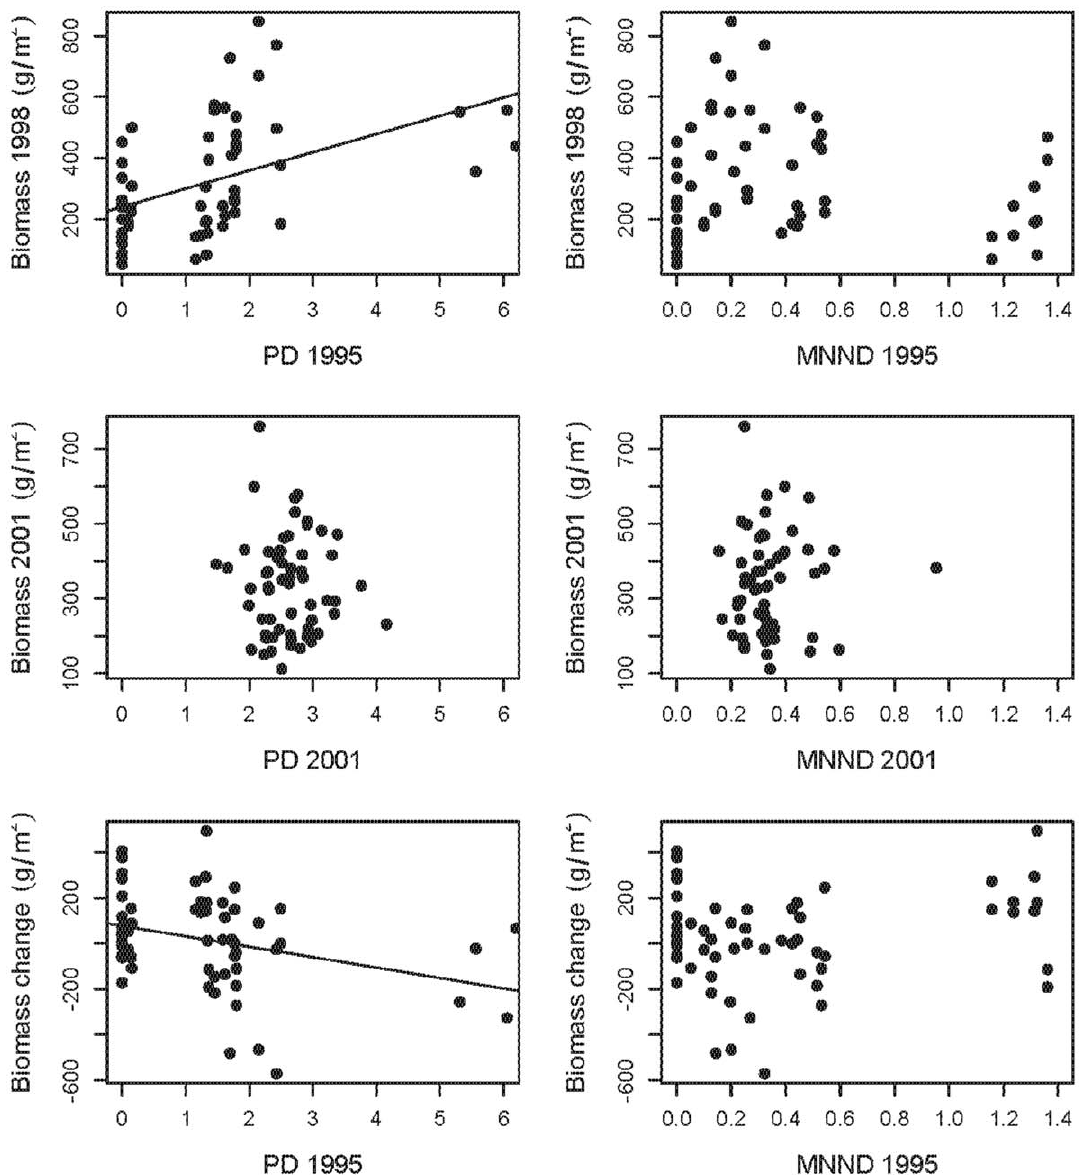
Figure 5. Measures of phylogenetic diversity (PD and MNND) and biomass production in 1998, 2001 and the change in biomass production. Regression line represents a statistically significant relationship.